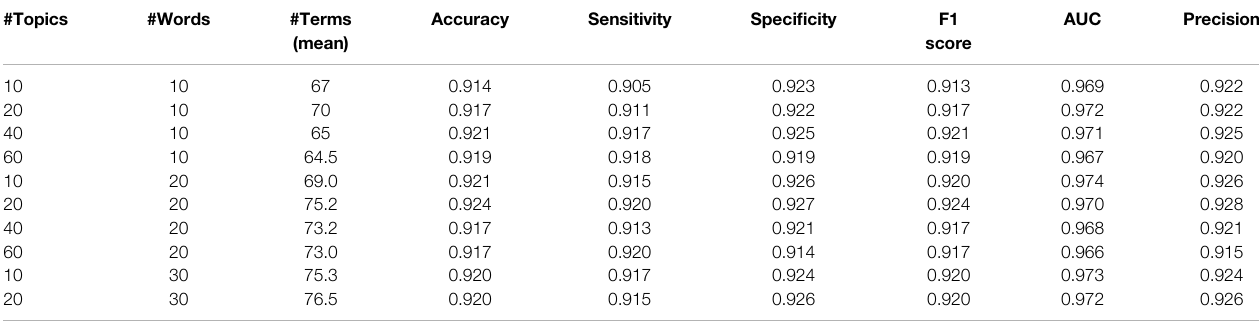
TABLE 3 | TextNetTopics performance metrics for different values of n_topics and n_topics_words for the CAMDA dataset over ten iterations. The top ~70 features are considered for comparison. #Topics